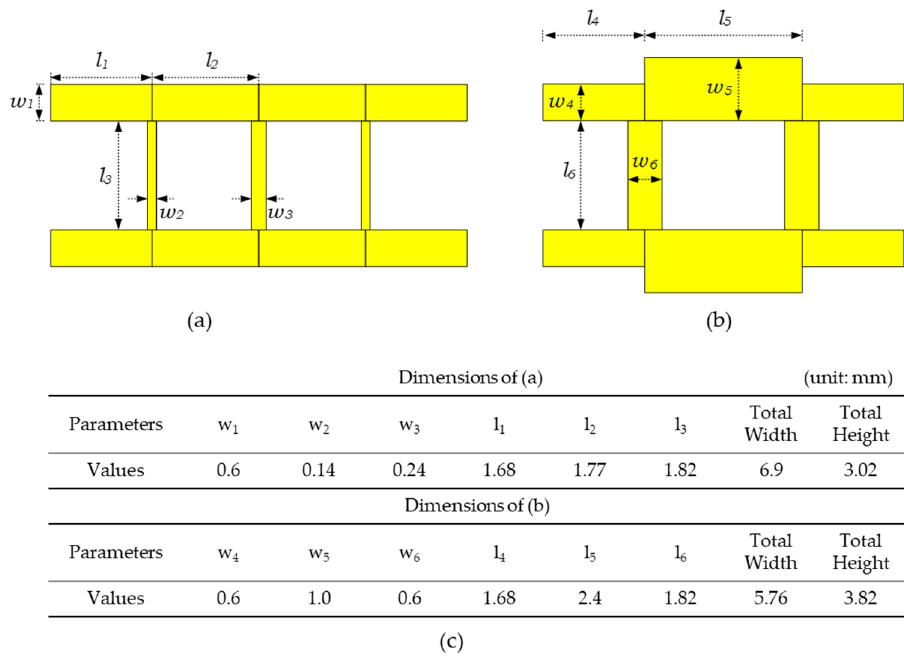
Figure 3. Brach-line hybrid coupler. ( a ) Proposed two-section structure, ( b ) conventional single-section structure, ( c ) dimensions.